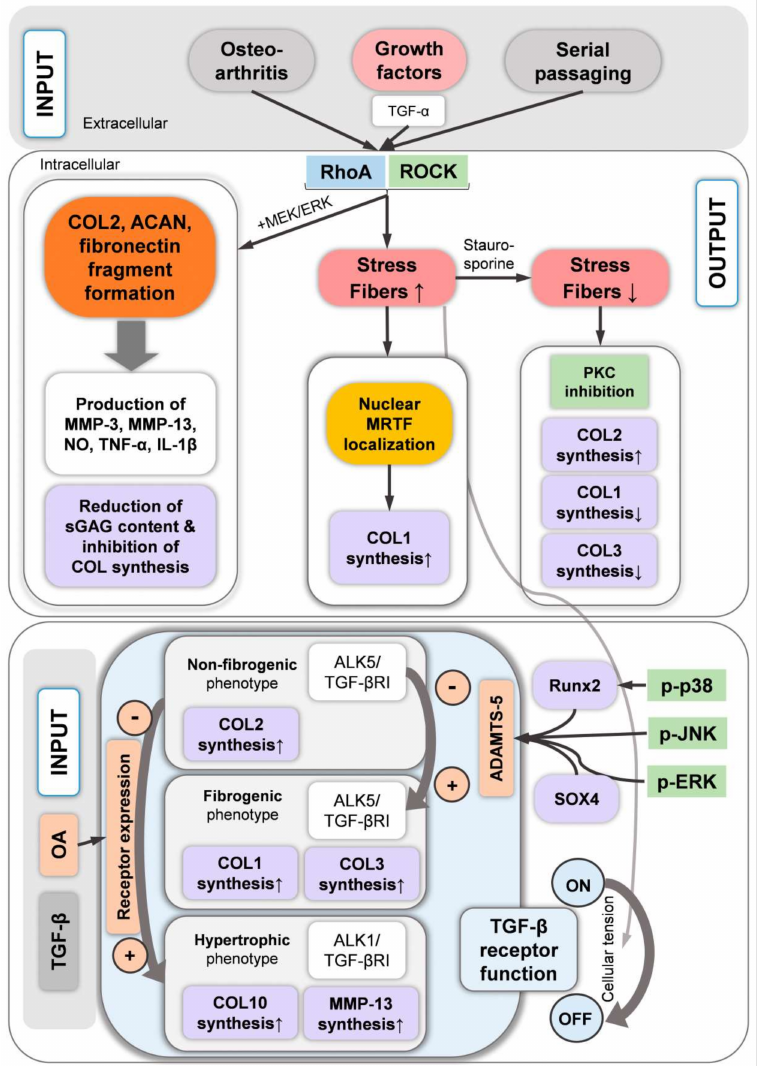
Figure 11. Effects of OA, growth factors, and serial passaging on stress fiber formation and the subsequent effects on TGF- β receptor function and CH phenotype. Abbreviations: ACAN: aggrecan, ADAMTS-5: a disintegrin and metalloproteinase with thrombospondin motifs 5, COL1: type I collagen, COL2: type II collagen, COL3: type II collagen, COL10: type X collagen, ERK: extracellular signal-regulated kinase, (s)GAG: (sulfated) glycosaminoglycan, JNK: JUN N-terminal kinase, MEK: mitogen-activated kinase kinase 1/2, MRTF: myocardin-related transcription factor, NO: nitric oxide, OA: osteoarthritis, PKC: protein kinase C, TGF- β RI: transforming growth factor β receptor I, TNF- α : tumor necrosis factor α , IL-1 β : interleukin-1 β , MMP-3: matrix metalloproteinase 3, MMP-13: matrix metalloproteinase 13, SOX4: SRY-box transcription factor 4. The up and down arrows indicate an increase or